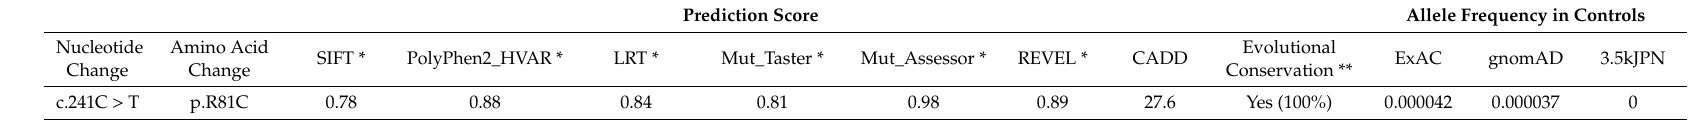
Table 1. Possible causative variant identified in this study.